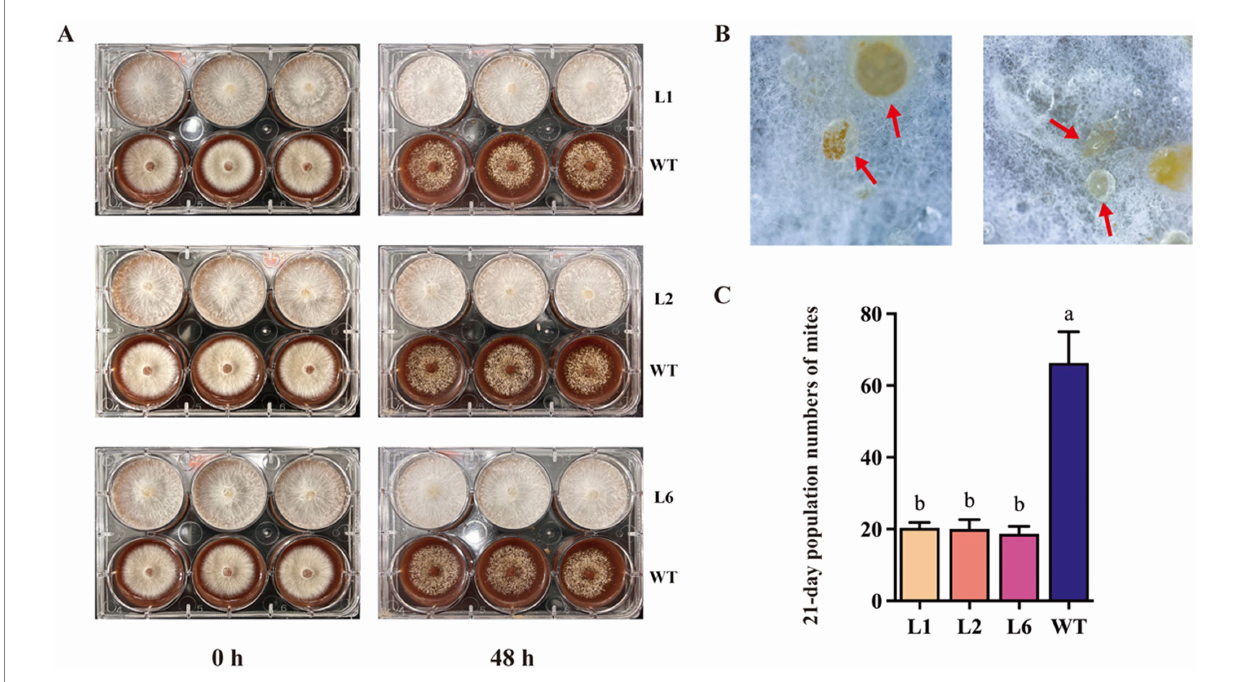
FIGURE 4 Polec2 overexpressing strains resistance to T. putrescentiae . (A) Infestation tests in Polec2 overexpressing strains (framed into blue square). (B) T. putrescentiae (red arrow) was buried in the mycelium of Polec2 overexpressing strains. (C) The 21-day population numbers of T. putrescentiae feeding on Polec2 overexpressing strains (L1, L2 and L6). Letters indicate significant differences from the WT strain ( p < 0.05, Waller-Duncan test).